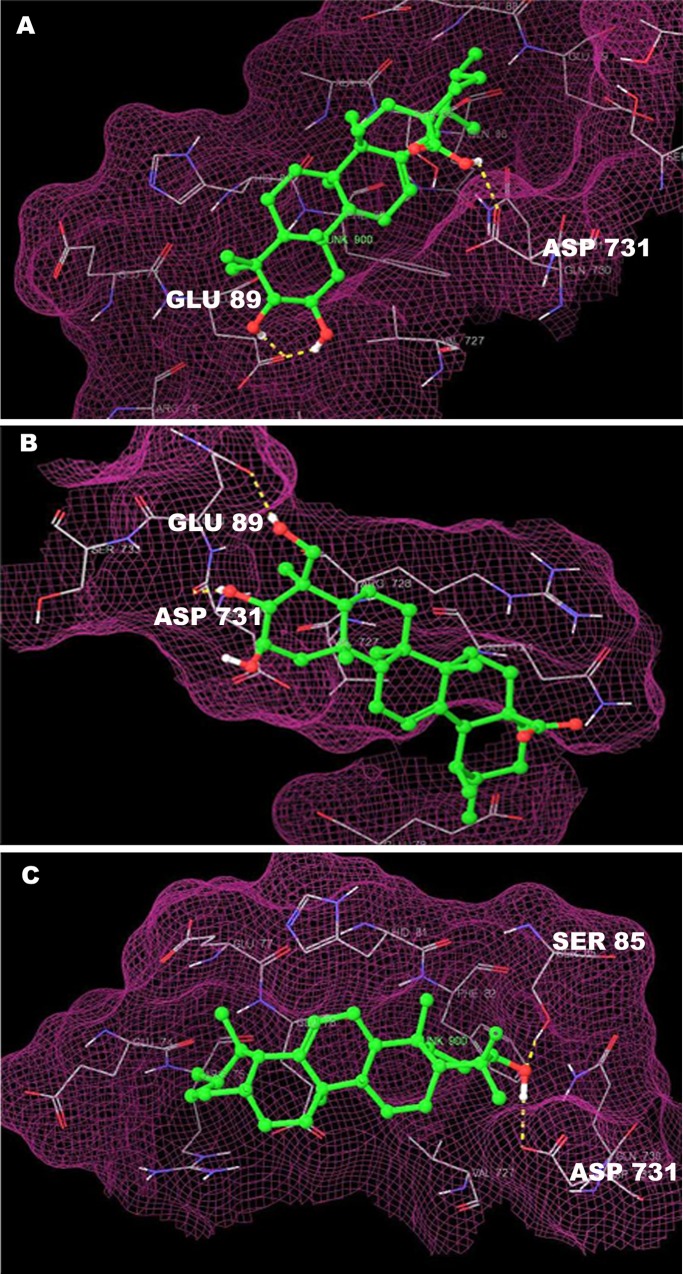
Hydrogen bond interaction of CA (A), AA (B) and UA (C) at GLU 89 and SER 85 gatekeeper residues of NEMO/IKKβ association complex (PDB code: 3BRV).